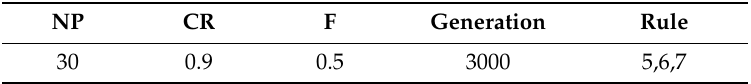
Table 1. Initial parameters of